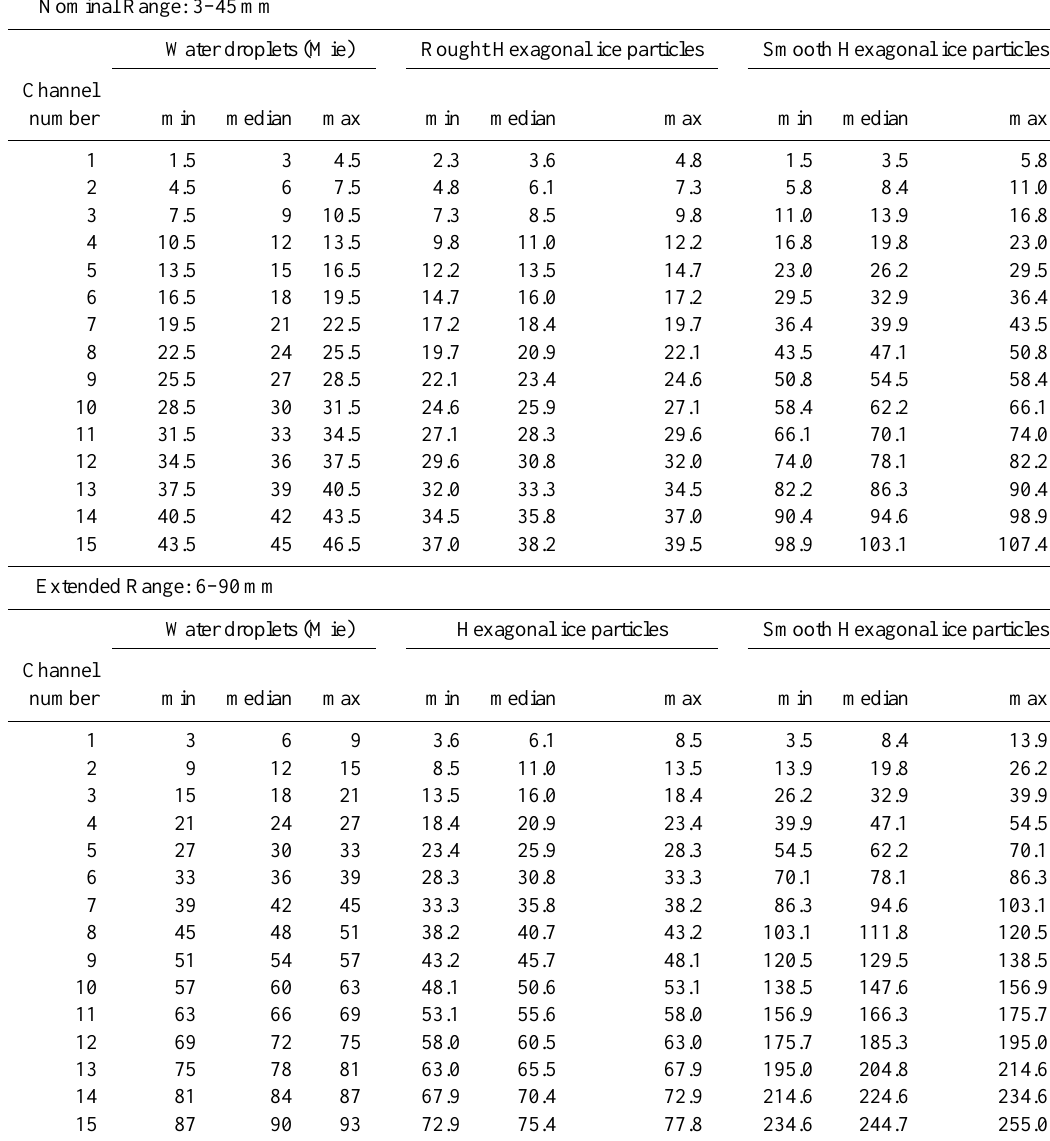
Table 2. Bin limit sizes for the FSSP-100 particle counter for water droplets (Mie calculations) and from hexagonal particles modelling for the refractive index of ice (1.31) assuming particles having a mean aspect ratio of 0.5. Results are reported for the nominal and extended size